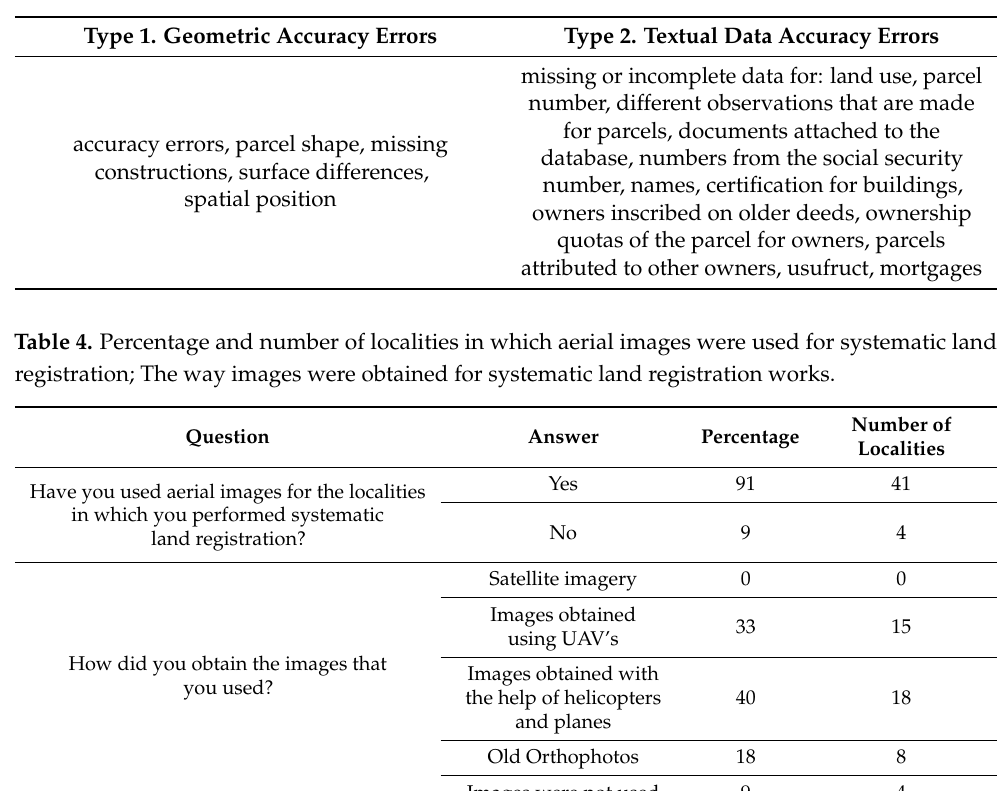
Table 3. Types of errors from the rejection papers.